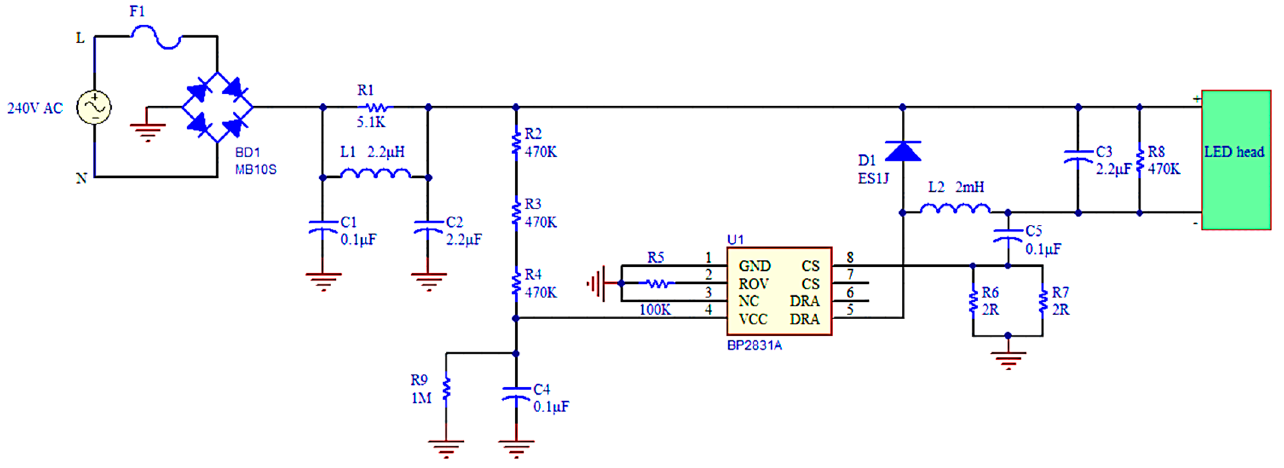
Figure 11. Diagram of the LED drive circuit with nominal values of component parameters (Sample A).